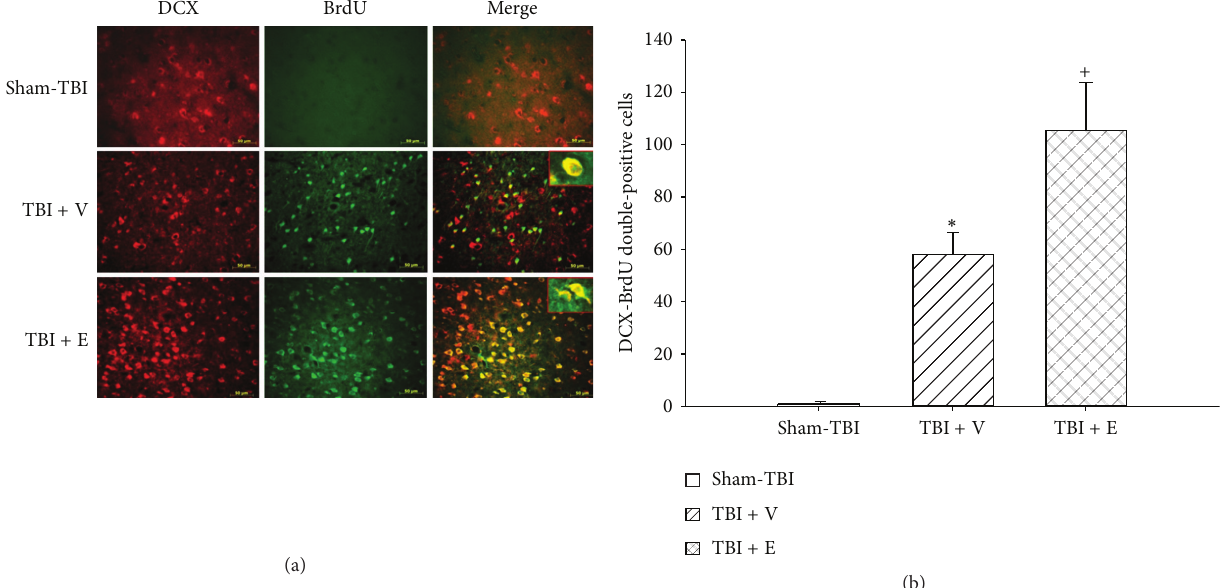
Figure3:Mean ± standarddeviationvaluesofthenumberofBrdU-DCX-positivecellsinthecoreischemiccortex.Sham-TBI(whitecolumn): rats given a sham traumatic brain injury (TBI) operation; TBI + V (lined column): TBI rats treated with vehicle solution; TBI + E (crossed column): TBI rats treated with etanercept solution. The data were obtained 7 days after TBI or sham-TBI operation ( 𝑛 = 8 ). ∗ 𝑃 < 0.05 compared with the sham-TBI group; + 𝑃 < 0.05 compared with the TBI + V group. Right panels depict representative DCX-BrdU double stainings for one sham-TBI rat, one TBI + V rat, and one TBI + E rat.